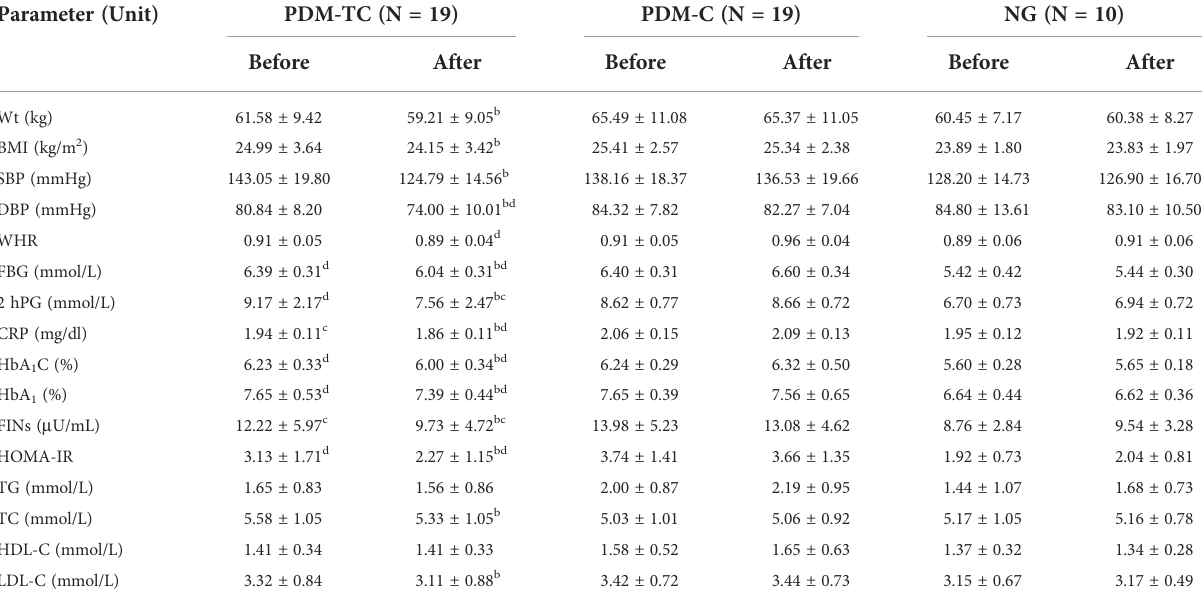
TABLE 1 Clinical characteristics of